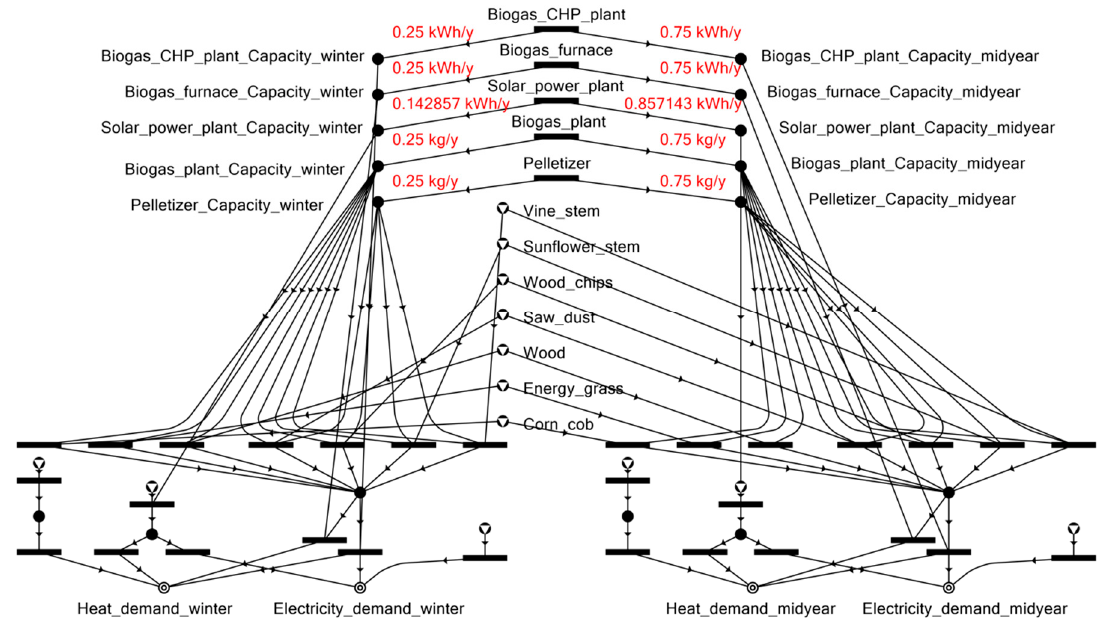
Figure 11. Final multi-periodic P-Graph model for the energy options of the manufacturing plant.